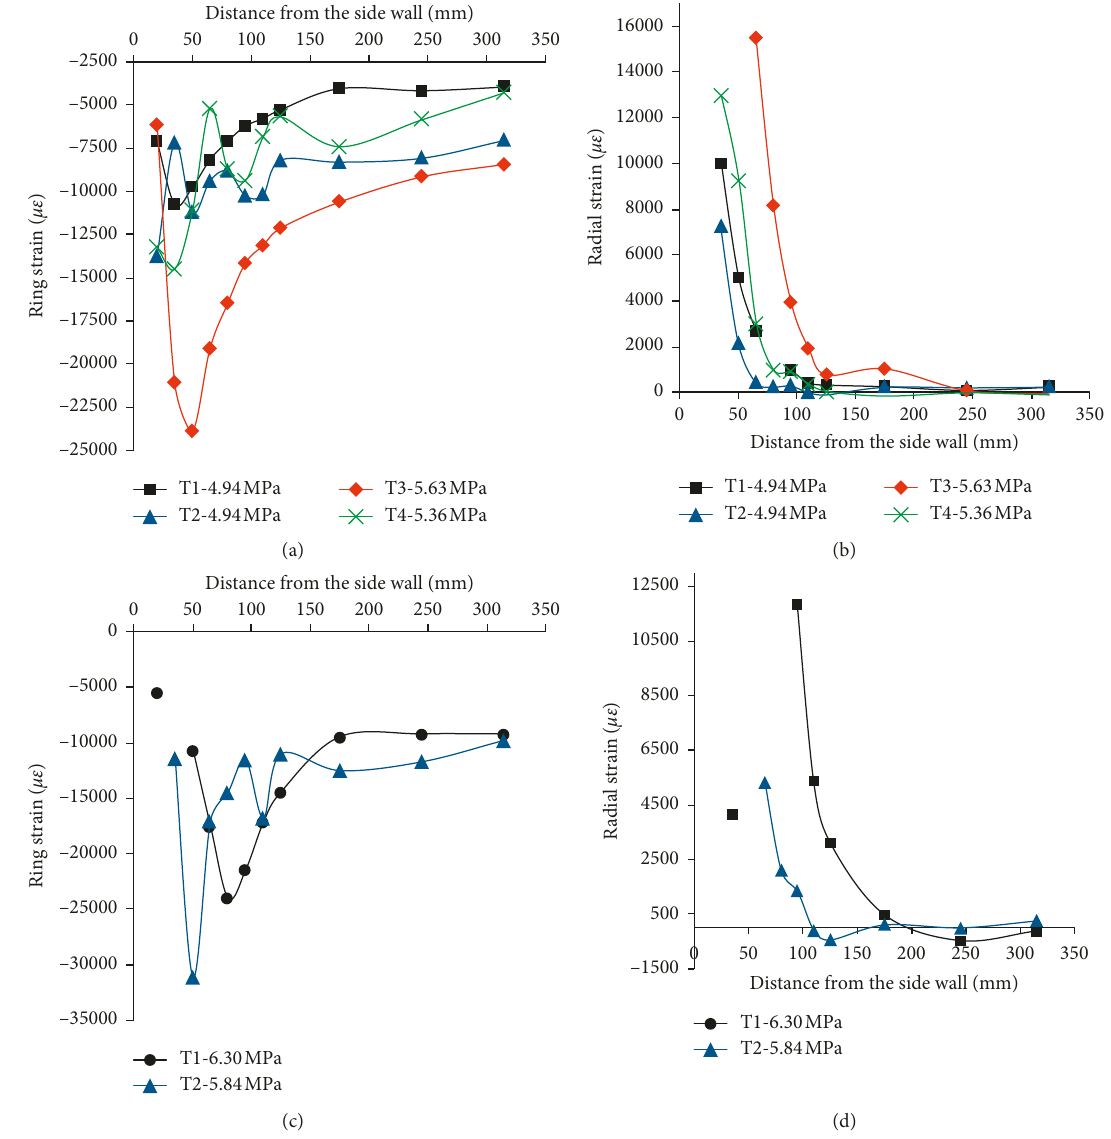
Figure 11: The strain in the surrounding rock mass during loading. (a) Ring strain at initial load. (b) Radial strain at initial load. (c) Ring strain at maximum load. (d) Radial strain at maximum